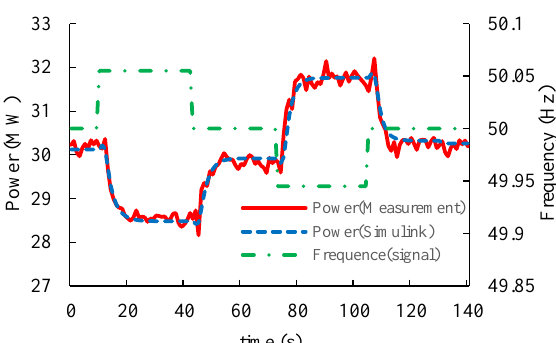
Figure 12. Comparison of active power change between hydropower plants (HPP) and the simulation model when the step signal is ±0.065 Hz.